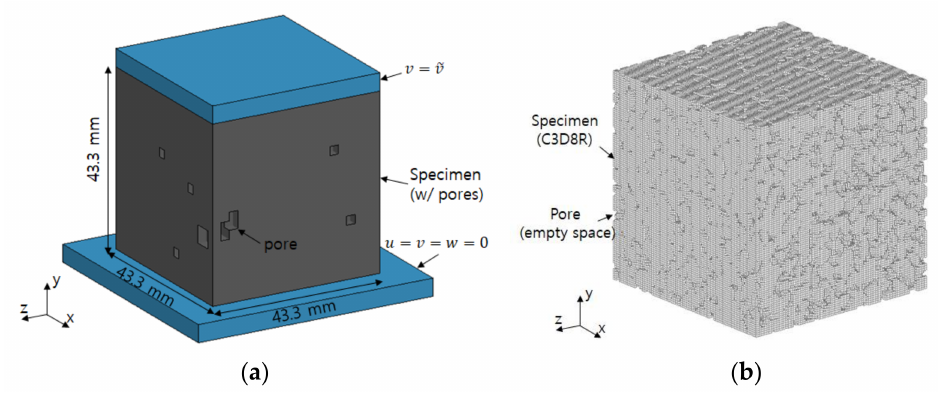
( a ) FE-based simulation configuration and ( b ) the representative FE modeling (specimen